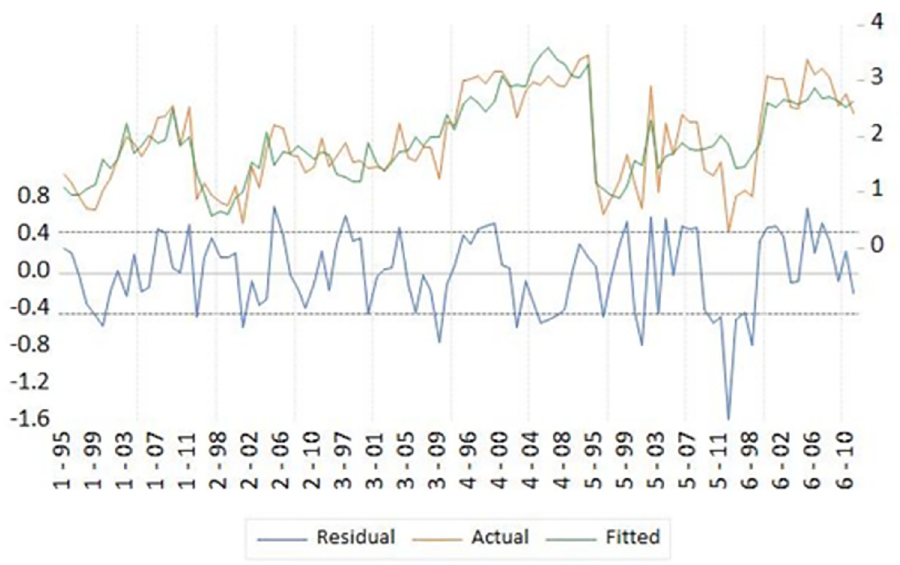
Fig 6. Residuals, actual and fitted values for l_price from the estimated